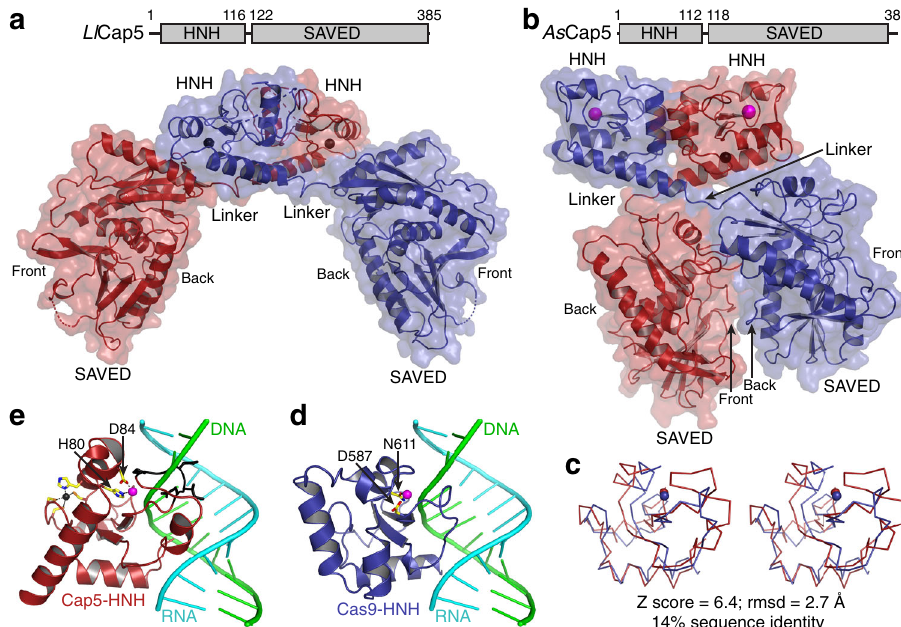
Fig. 3 Crystal structures of unliganded Cap5. a Cartoon and surface depiction of the structure of Ll Cap5. Cap5 forms a homodimer, and two monomers are colored red and blue, respectively. Zn 2 + ions are in the sphere and colored black. b Structure of As Cap5. Additional Mg 2 + ions in the active sites of HNH domains are in sphere and colored magenta. c Stereoview of structural superposition of HNH domain from As Cap5 (red) to the one from Cas9 (blue). The structures are depicted in ribbon, and Mg 2 + ions are in sphere. d Structure of Cas9-HNH domain in complex with DNA • RNA hybrid. Two residues coordinating a Mg 2 + ion are in stick and colored individually, with carbon in yellow, oxygen in red, and nitrogen in blue. e Structure of As Cap5-HNH domain with the modeled DNA • RNA hybrid from d . In addition to coordination of a Mg 2 + ion, a zinc fi nger, which is absent in Cas9-HNH domain, is also depicted in the stick, with the Zn 2 + ion in black and the sulfur atom in orange. The peptide having a steric clash with the DNA strand of the modeled DNA • RNA hybrid is colored black and depicted in the